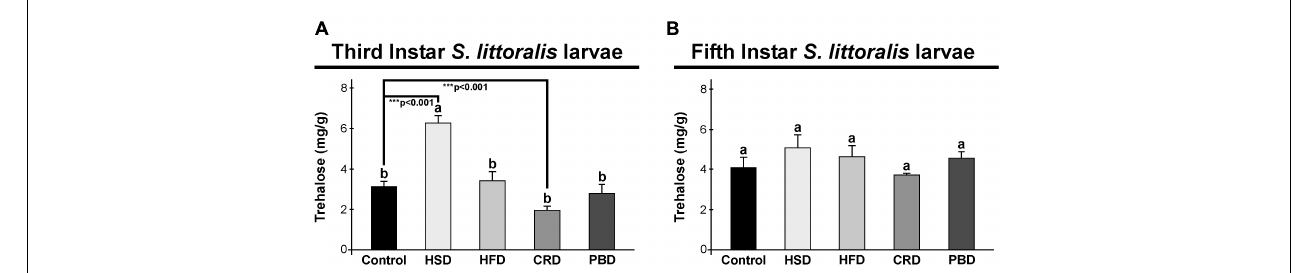
FIGURE 3 | Effects of different diet treatments on the trehalose levels of Spodoptera littoralis . Trehalose levels at third (A) and fifth instar (B) larval bodies are shown as mg in 1 g body weight. Statistical significances in the entire sample set were determined by using one-way ANOVA, followed by a Tukey HSD test (groups associated with different letters are significantly different among each other, p < 0.05). A t -test was used for binomial comparisons (diet treatment vs control) (*** p < 0.001 indicate the statistical differences between the particular diet and the control). Values are expressed as means ± standard error. Control, Regular artificial bean diet; HSD, High sugar diet; HFD, High fat diet; CRD, Calcium-rich diet; PBD, Plant-based diet.